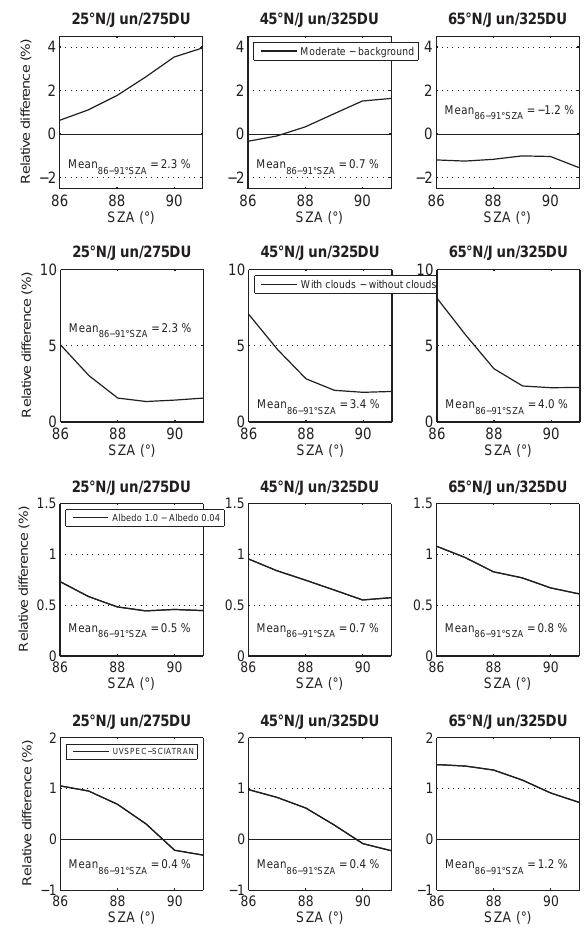
Fig. 5. From top to bottom, comparison of O 3 AMFs calculated us- ing standard and moderate volcanic aerosol settings, with and with- out the presence of clouds, with surface albedo fixed to 1.0 and 0.04, and with UVSPEC and SCIATRAN RTMs. The mean rela- tive difference calculated in the 86–91 ◦ SZA range appears on each plot. In case of the aerosols sensitivity test, the overall mean relative difference over the 86–91 ◦ SZA range is of 0.6% while it reaches 3.3%, 0.7%, and 0.7% for the test on clouds, surface albedo, and RTMs, respectively. The O 3 profiles selected from the TV8 clima- tology for the present comparison correspond to the following con- ditions: 25 ◦ N/275DU (left plots), 45 ◦ N/325DU (middle plots), and 65 ◦ N/325DU (right plots) in June. The wavelength, surface albedo, and altitude are fixed to 500nm (541nm for test on RTMs), 0.2, and 0km, respectively. O 3 AMF are mostly impacted by the presence of clouds (stratus layer in the present case), reducing the AMF by 3.4% on average in the 86–91 ◦ SZA range at mid-latitude.